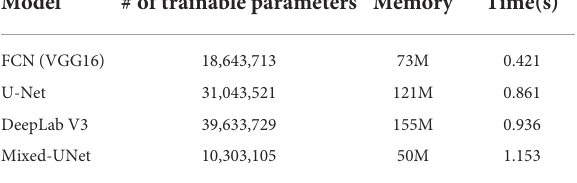
TABLE 4 A comparison of computational time and hardware resources required for various deep